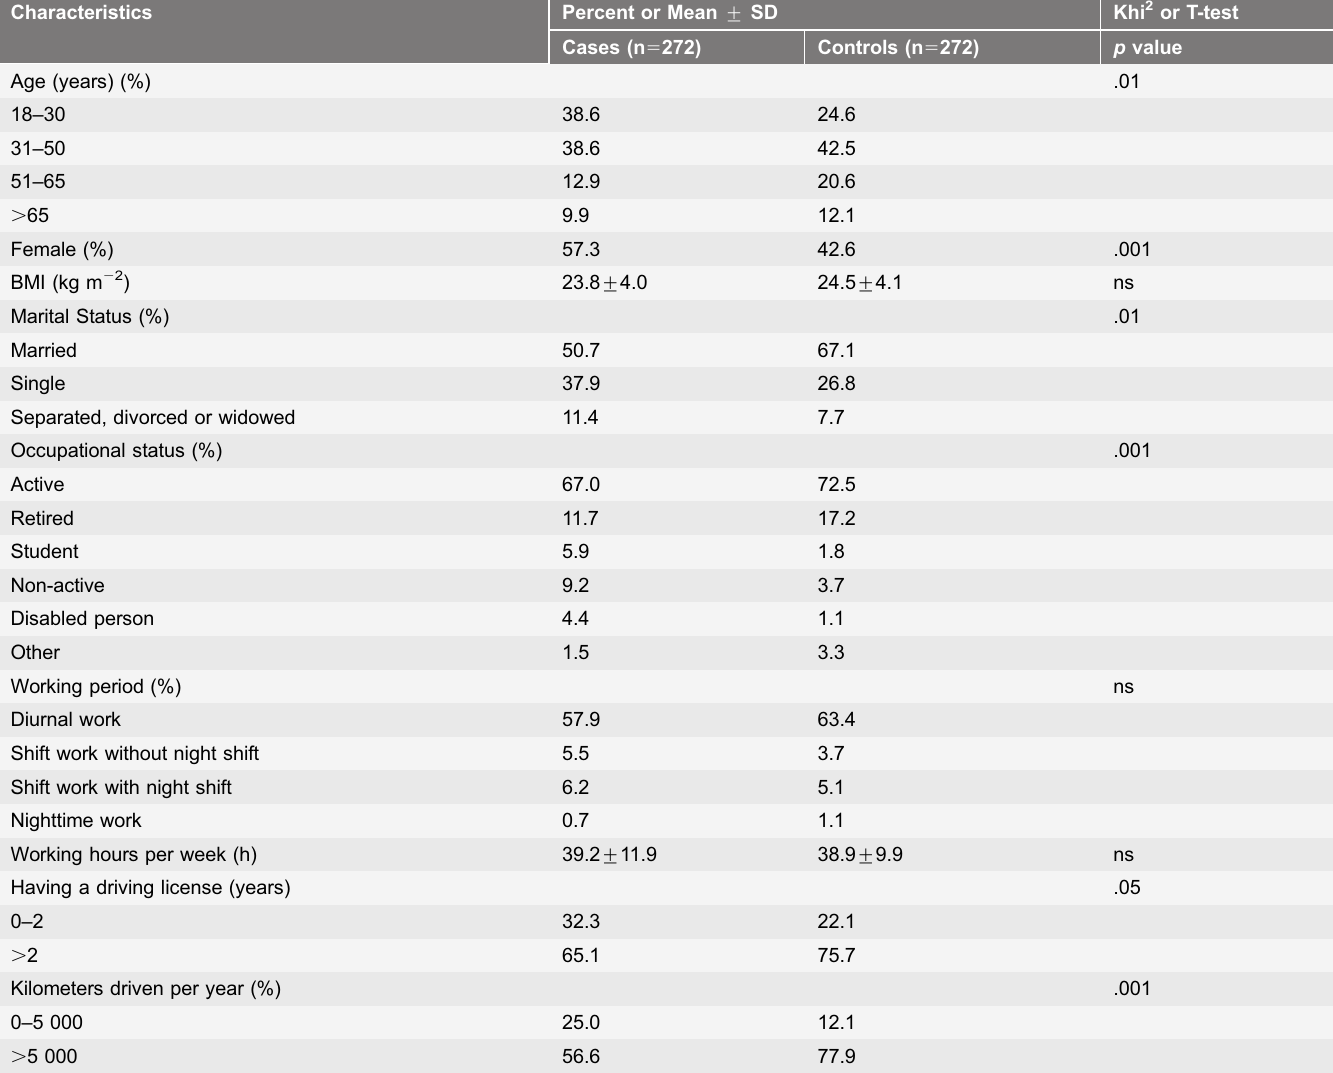
Table 1. Demographic characteristics of cases (i.e., drivers admitted to emergency unit at hospital) and controls (i.e., drivers interviewed during road checks carried out by the police).